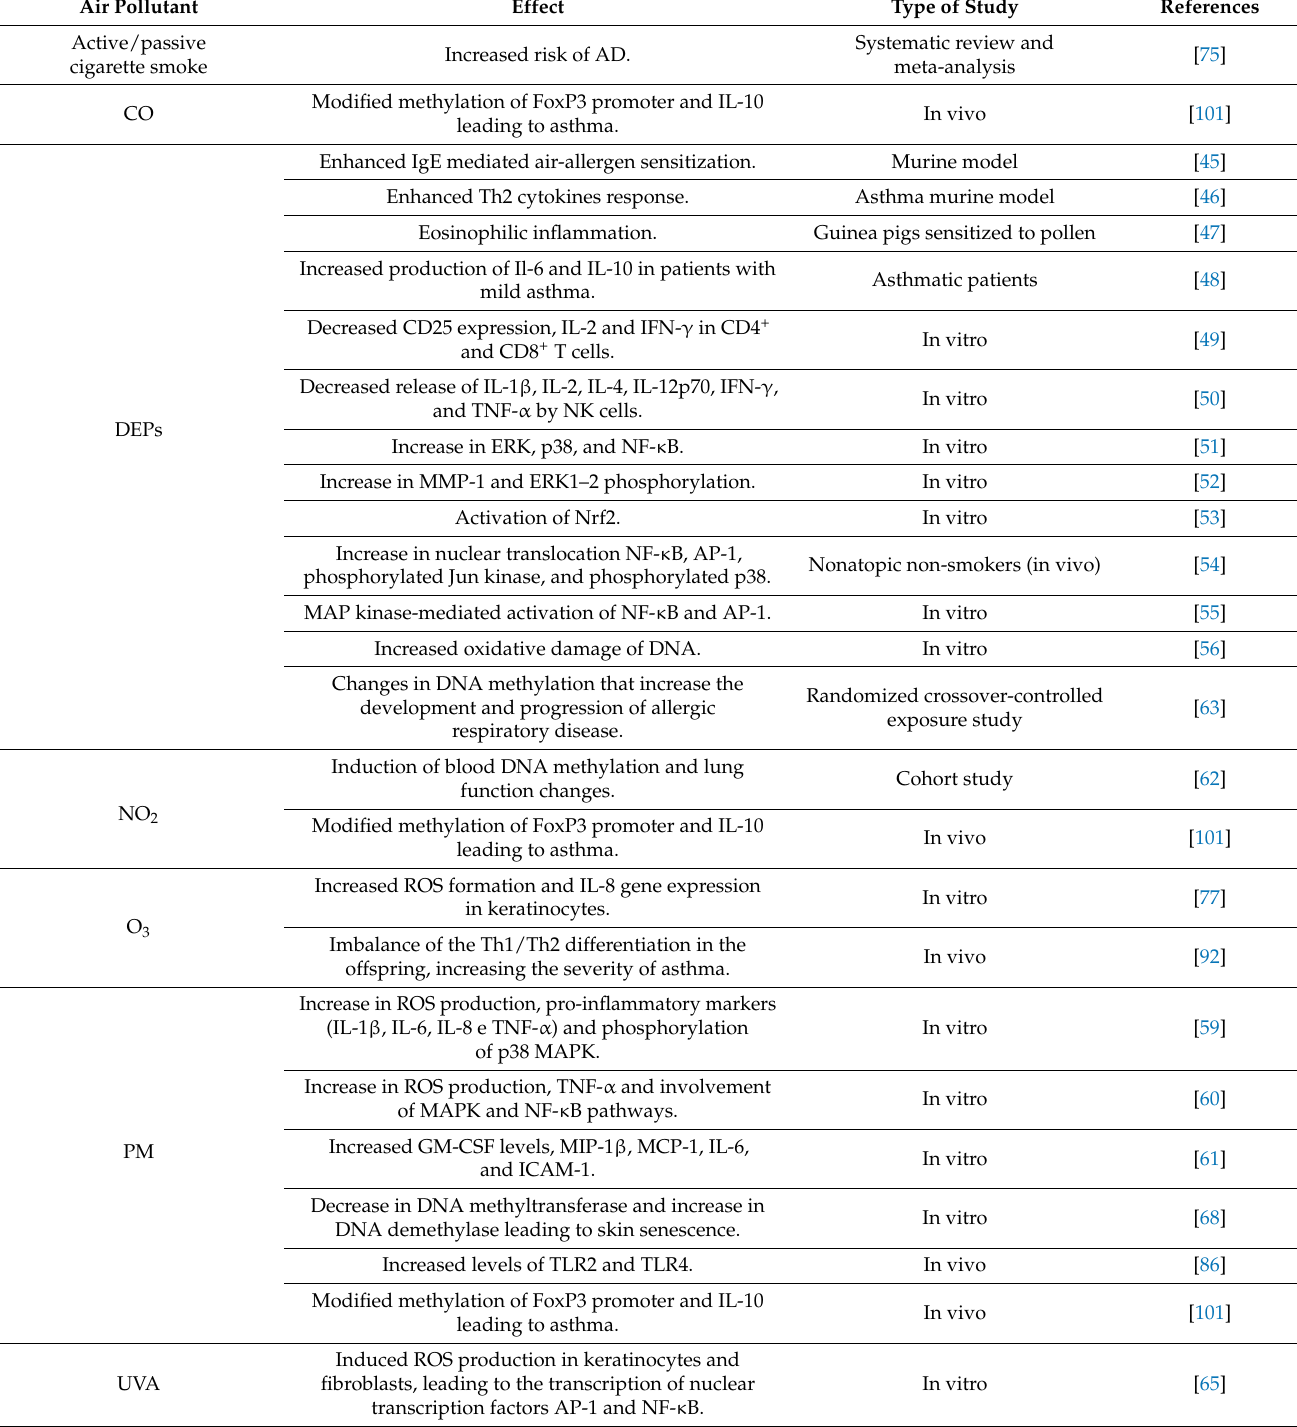
Table 2. Summary of air pollutant effects on the immune